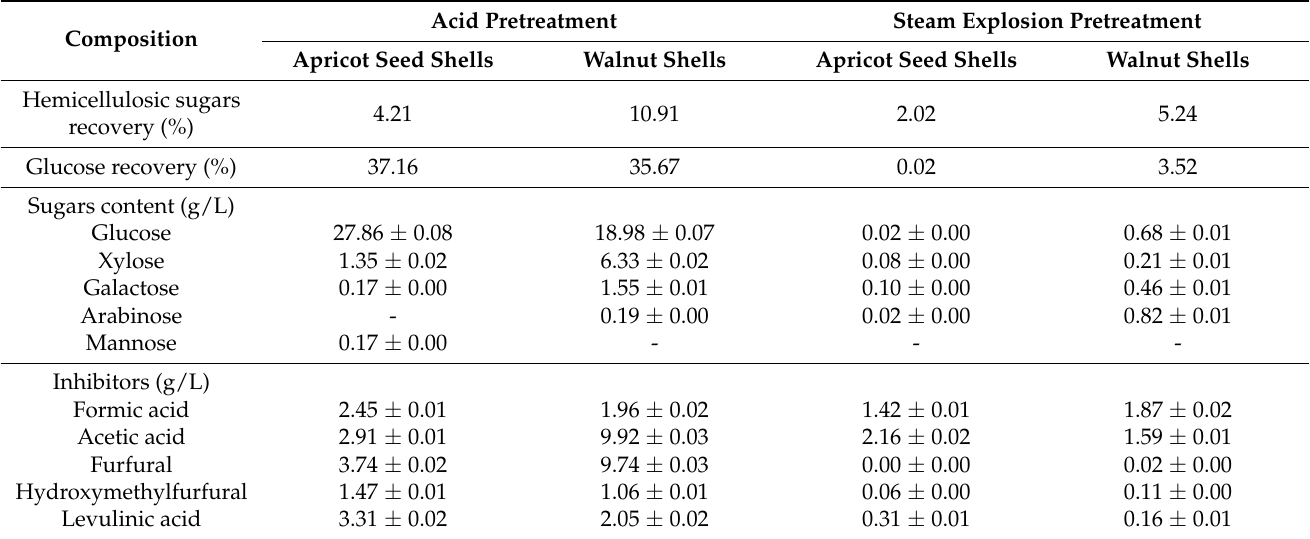
Table 3. Hydrolysate characterization after acid and steam explosion pretreatment of raw